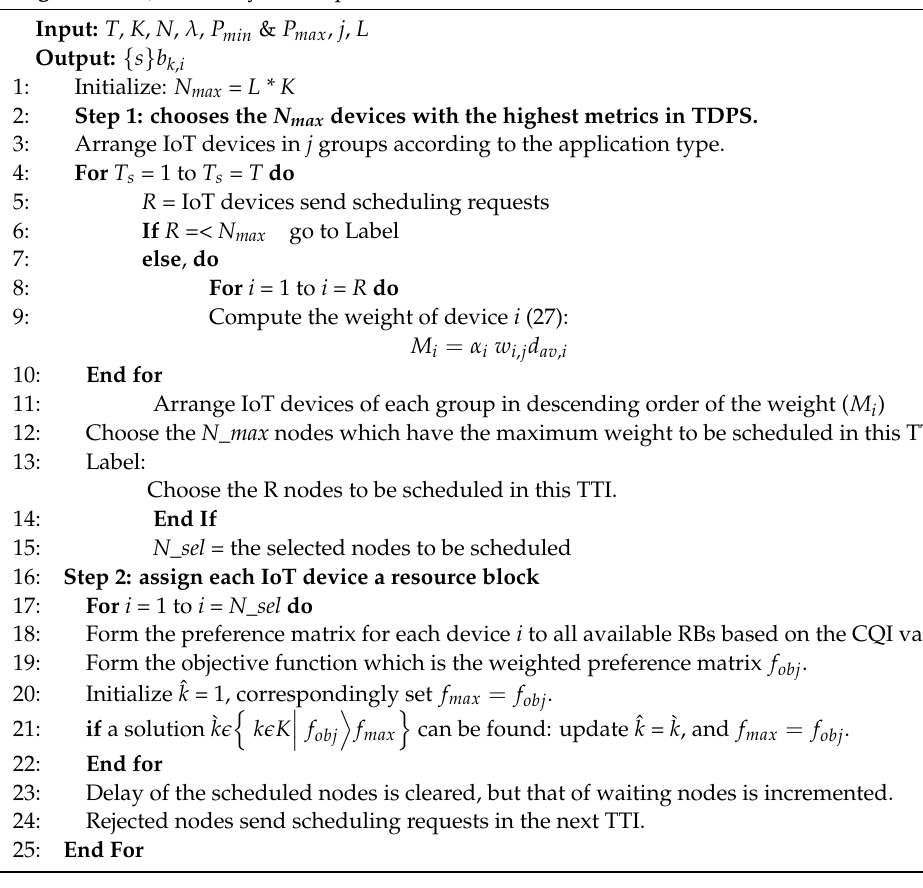
Algorithm 1. Joint Delay-Rate Optimization